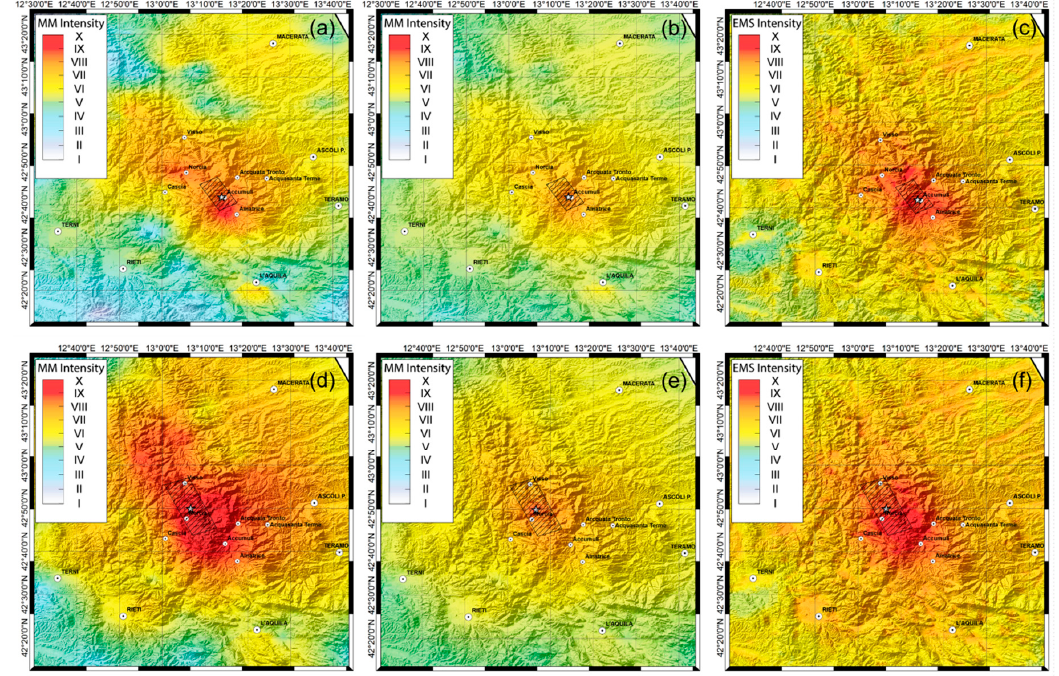
Figure 11. Comparison among intensity maps obtained according to the models proposed by Tselentis and Danciu [29] ( a , b , d , e ) and official ShakeMaps ( c , f ) according to Faenza and Michelini (2010), available online (http://shakemap.rm.ingv.it/shake/). The proposed maps obtained through T&D08 ( a , d ) and T&D08-2 ( b , e ) are the mean of those based on cumulative absolute velocity and Arias intensity for the M W 6.0 Amatrice (upper layer) and M W 6.5 Norcia earthquakes (lower layer).